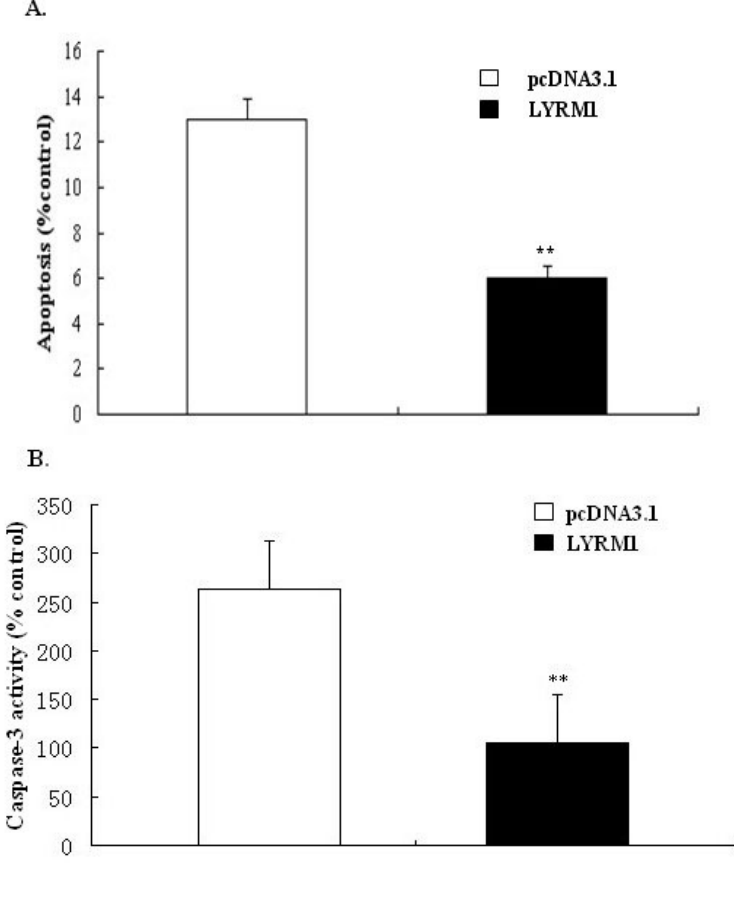
Figure 3. Effect of LYRM1 on cell apoptosis. Apoptosis was assayed by detecting binding of annexin V-FITC (A) and caspase-3 activity (B). Data from both assays showed